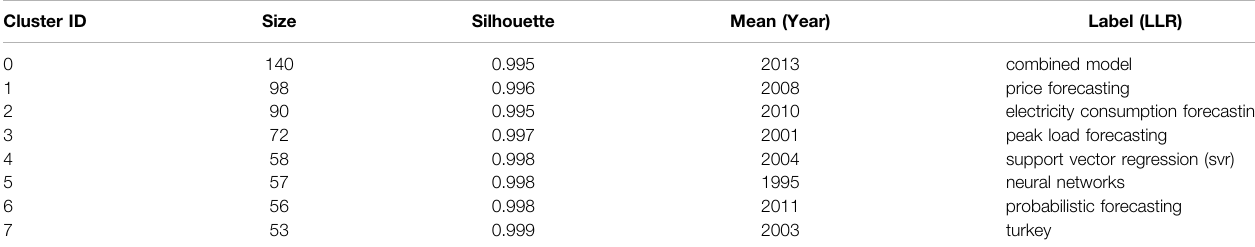
TABLE 8 | Largest clusters of co-cited references, 1999 –